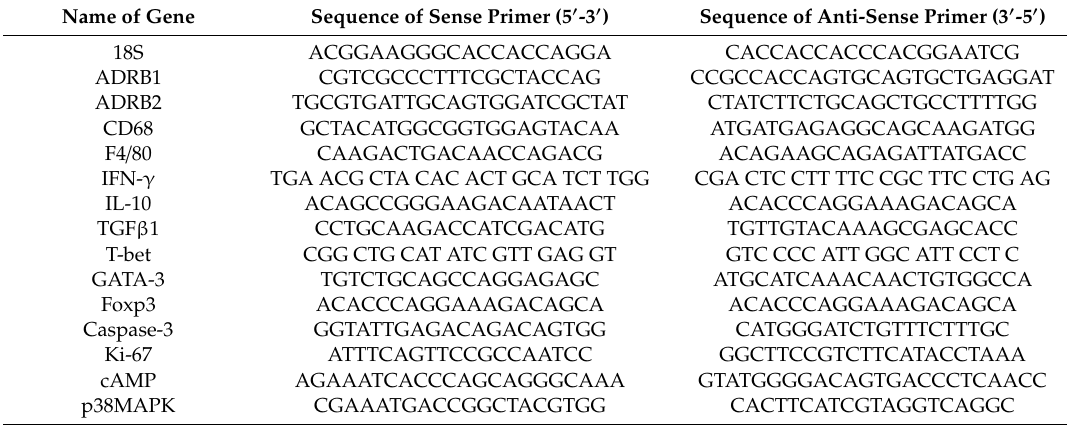
Table 1. Primer sequences used for various genes expression analysis by real-time qPCR. Name of Gene Sequence of Sense Primer (5 (cid:48) -3 (cid:48)